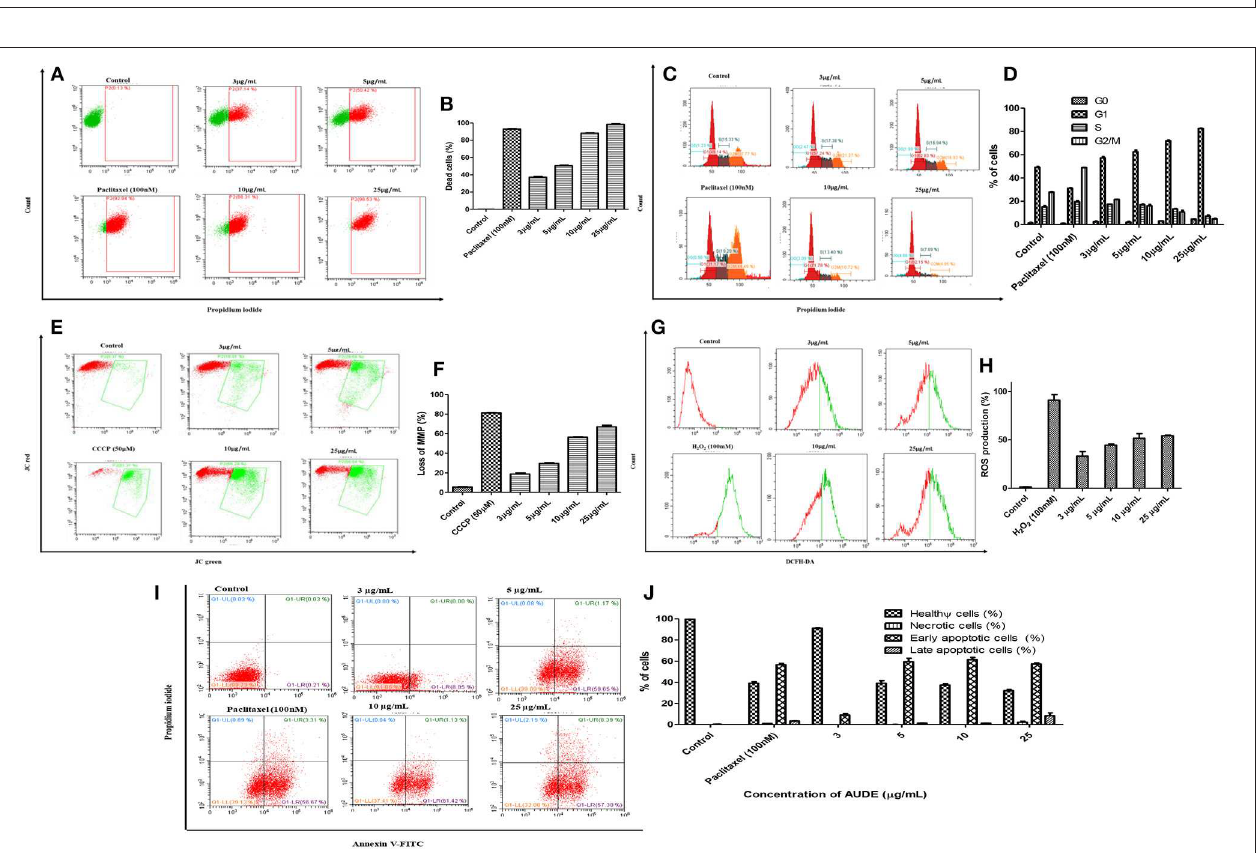
FIGURE 7 | Mechanism of cell death induced by AUDE treatment in A431 cells as determined by FACS analyses: (A,B) PI staining after 24h of treatment. (C,D) Effect of AUDE treatment on cell cycle arrest after 24h in A431 cells stained with PI. (E,F) Effect of AUDE treatment on mitochondrial membrane potential after 24h in A431 cells, stained with JC-1. (G,H) Effect of AUDE treatment on ROS production after 24h in A431 cells, using DCFH-DA dye. (I,J) Effect of AUDE treatment on externalization of phosphatidylserine in A431 cells after 24h, using annexin FITC/PI dual staining.